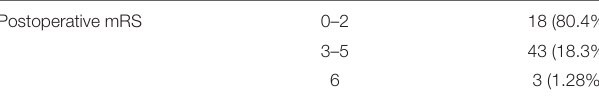
TABLE 3 | The modified Rankin Scale (mRS) of the postoperative